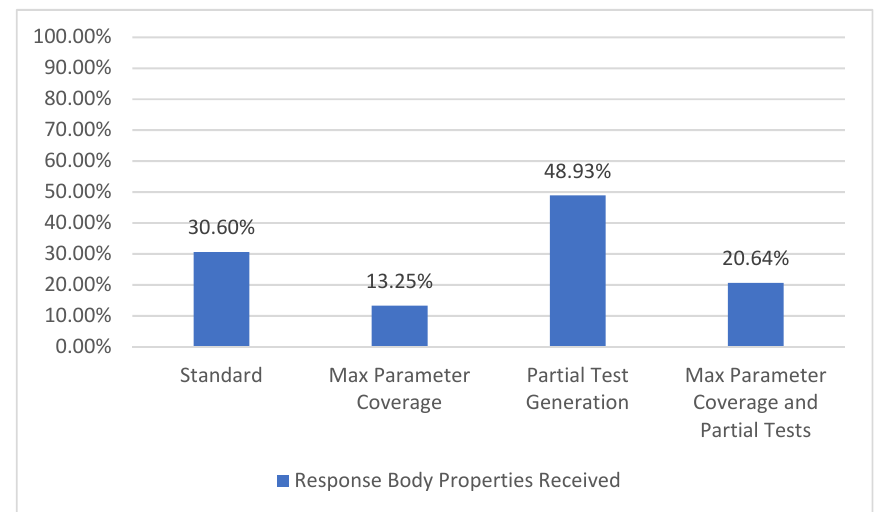
Figure 14. Response body property coverage.